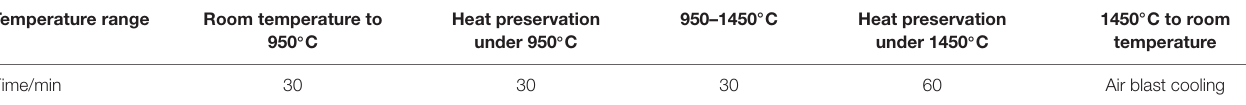
TABLE 2 | Calcination program of the cement